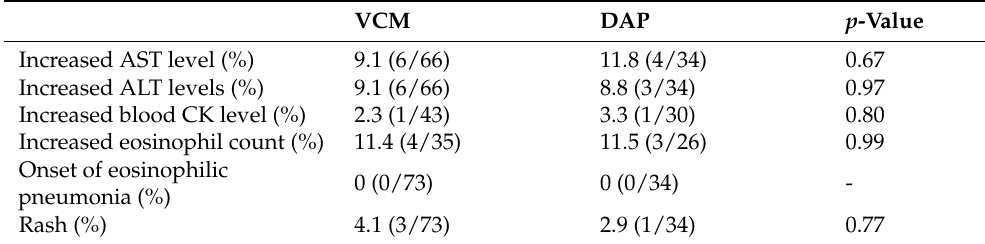
Table 3. Safety data of the registered